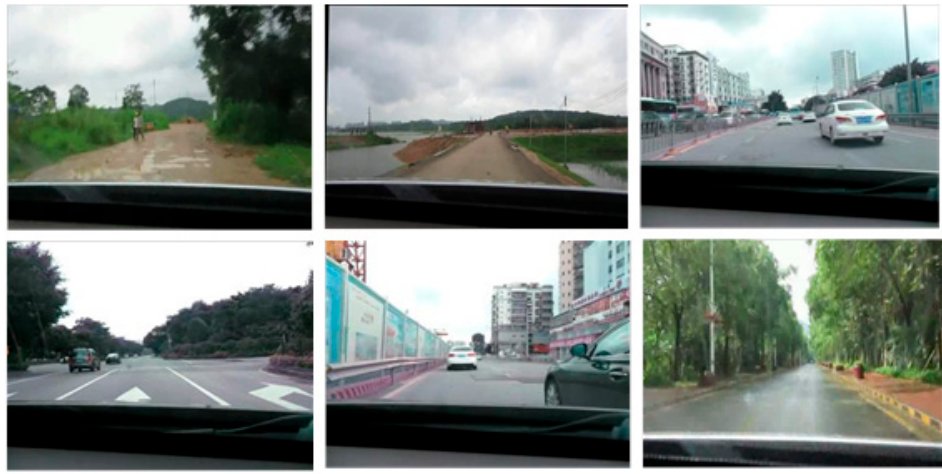
12 of 14 Figure 20. Images ( a ) and ( b ) refer to the IDI between the ( k − 1)th and the k th frames in the original and stabilized sequences, respectively; images ( c ) and ( d ) refer to the IDI between the k th and the ( k + 1)th frames in the original and stabilized sequences. Figure 21. PSNR values illustrated for the original video (in Blue ) and the stabilized video (in Red ). 3.4. Performance Assessment Using the Video Sequences with Increasing Vehicle Speed In this section, the algorithm performance is assessed by using the vibration video sequences at 30 fps, with increasing vehicle speeds of 20 km/h, 40 km/h and 60 km/h. Six sample frames in the